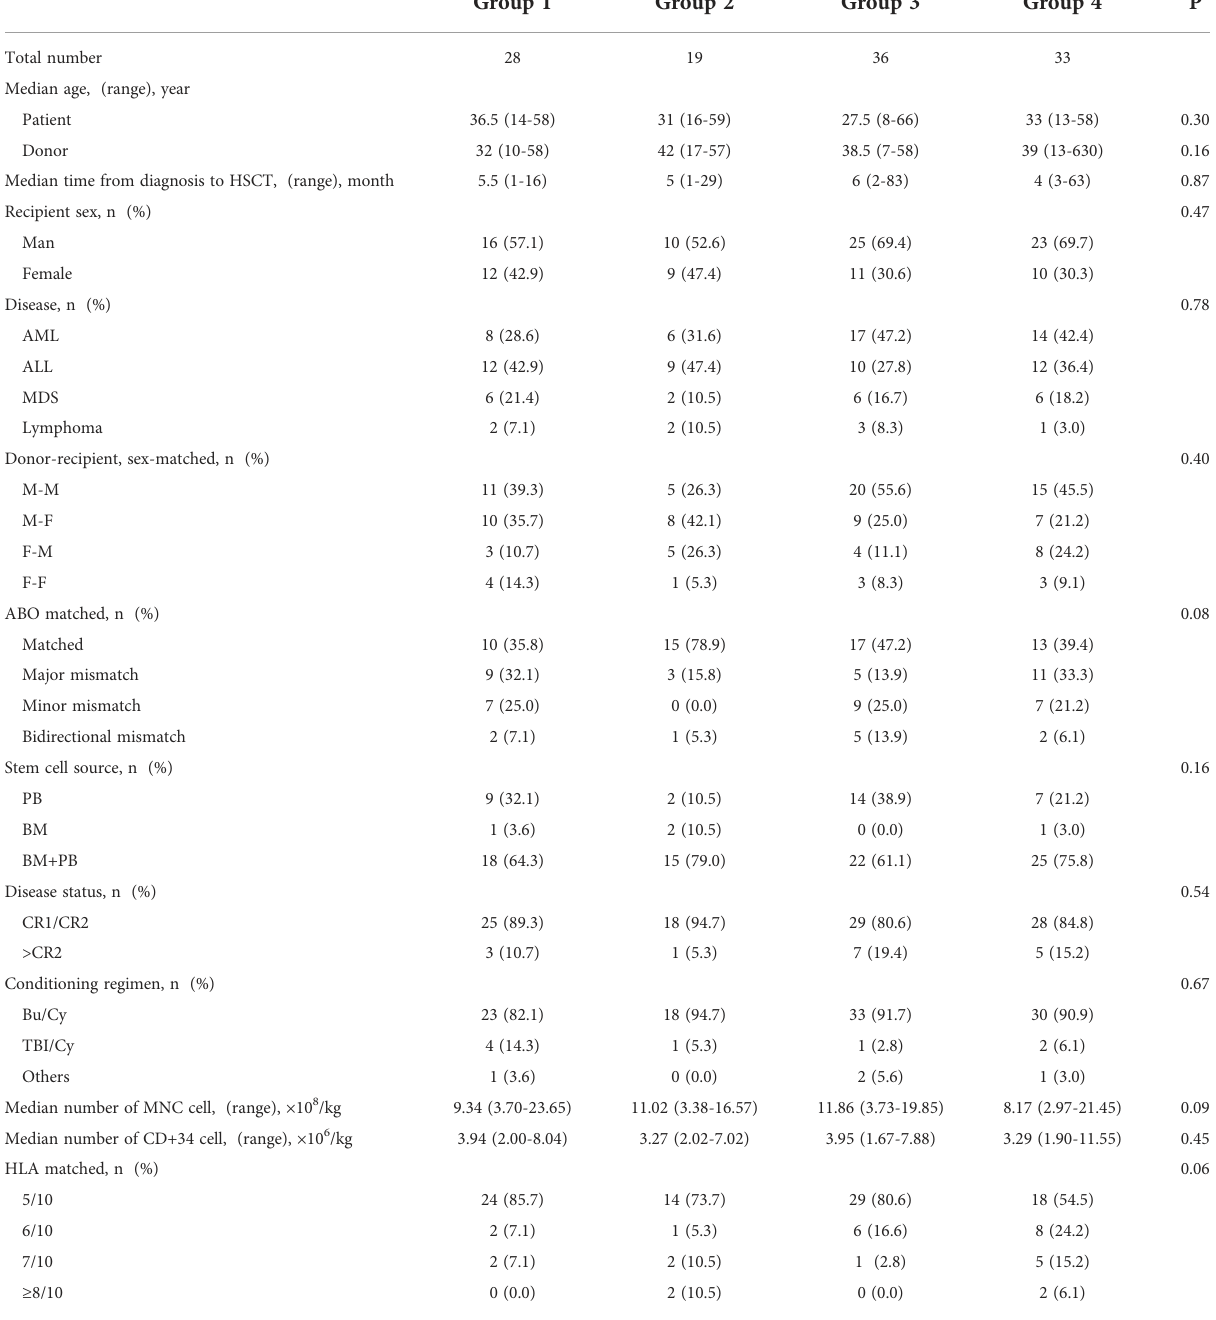
TABLE 1 Clinical characteristics of 116 patients with malignant hematological diseases. Group 1 Group